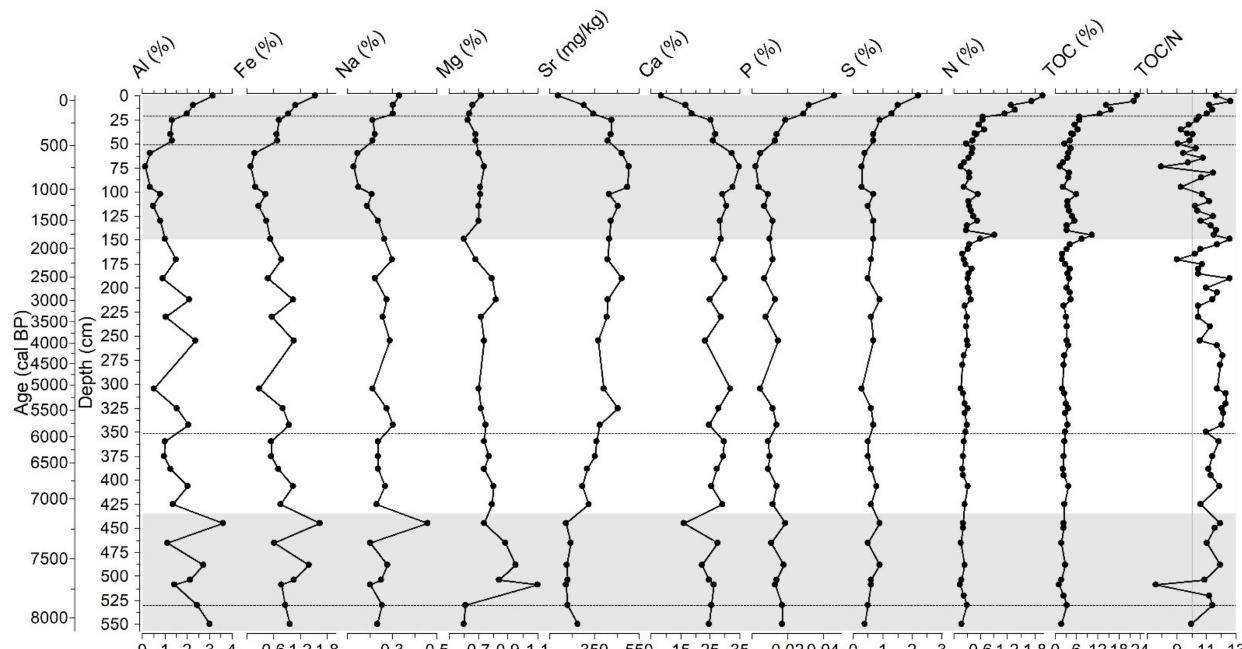
Figure 8. Selected major and trace element concentrations, and N, TOC, and TOC/N values in the sediment core VB-2 from Lake Velo Blato. The grey-shaded and white horizontal bars indicate the changes in sedimentary deposition zones explained in the